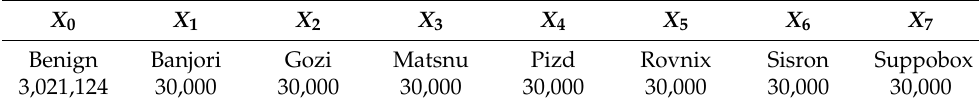
Table 2. Numbers of benign and malicious domains in the datasets.